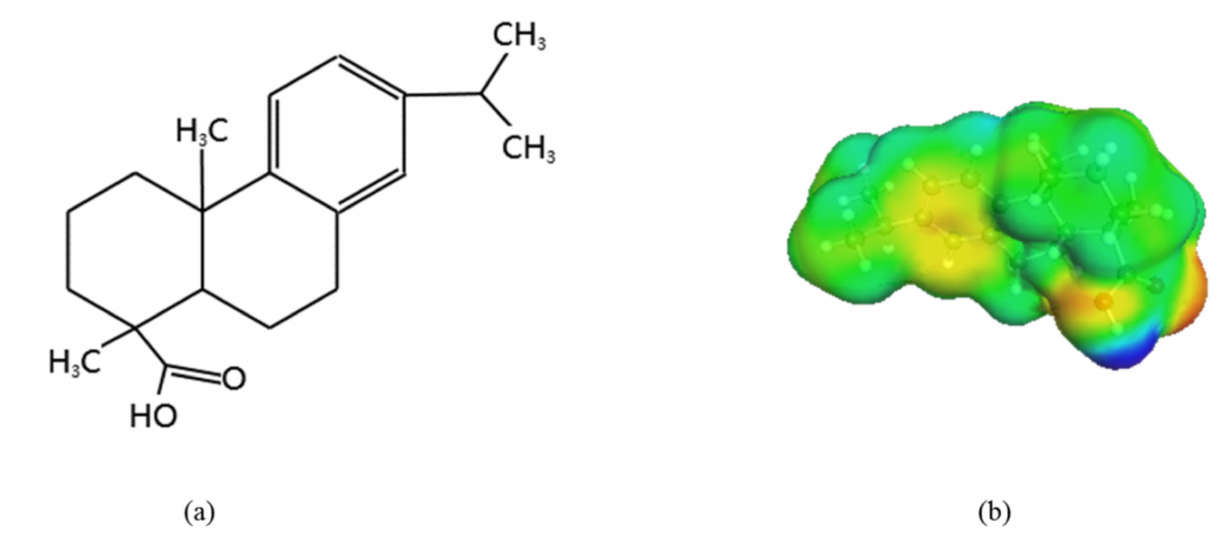
Figure 1. The molecular structure ( a ) and sigma surface ( b ) of dehydroabietic acid. The different colors shown in the sigma surface of benorilate have the following meanings: the red part represents the hydrogen acceptor region; the blue part represents the hydrogen donor region; and the green part represents the nonpolar